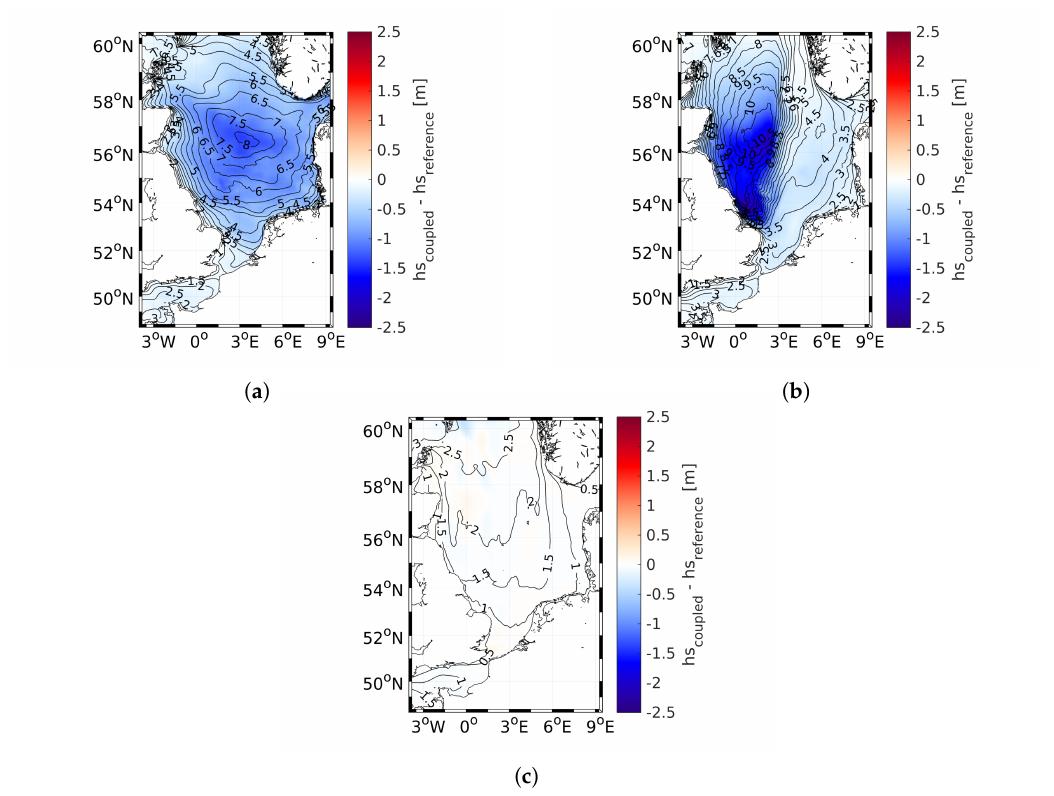
Figure 13. Absolute values of the significant wave height in the reference model simulation (contours) and the differences in the significant wave height between the coupled and reference model simulations (coloured) on ( a ) 11 January 2017 at 12:00 p.m. UTC; ( b ) 13 January 2017 at 12:00 p.m. UTC; and ( c ) 16 January 2017 at 6:00 a.m. UTC.